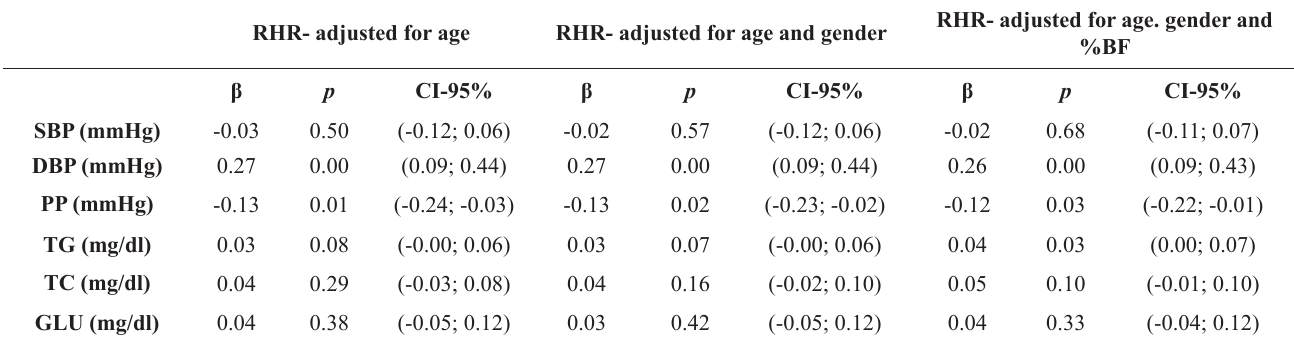
RHR- adjusted for age. gender and %BF